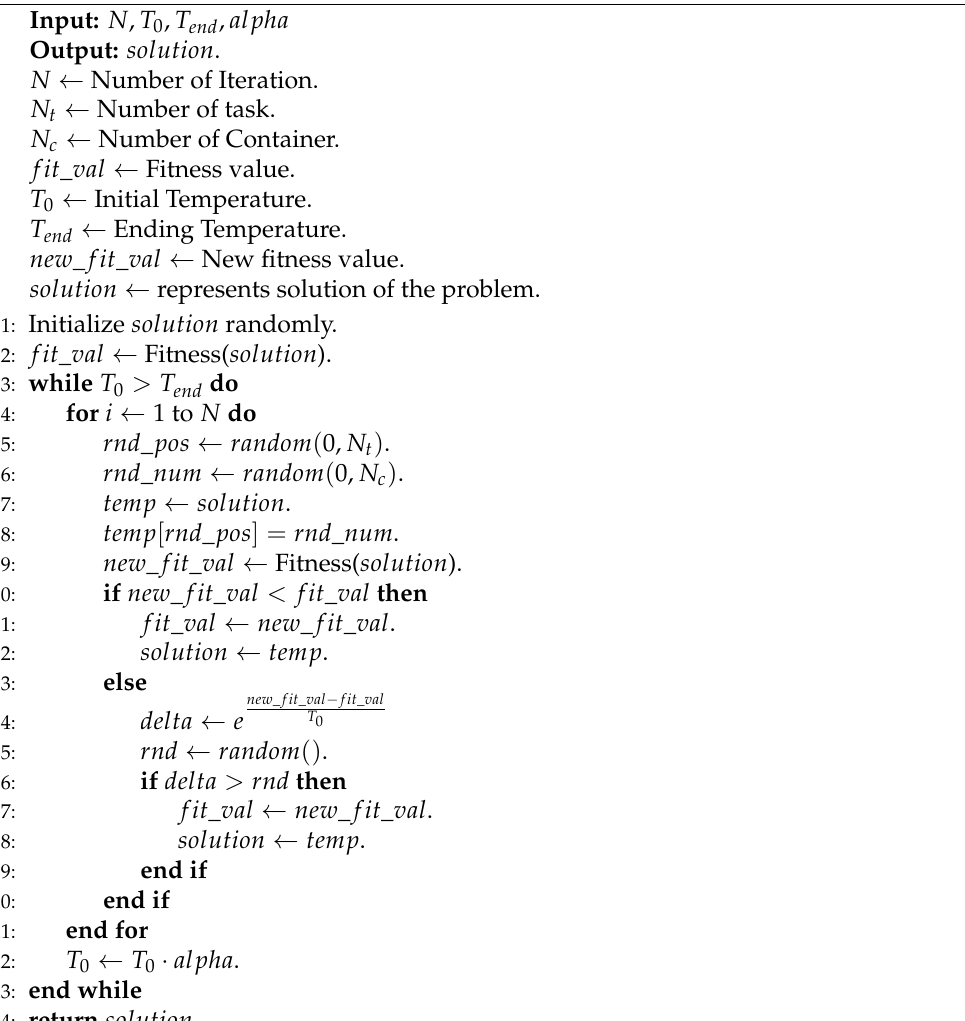
Algorithm 3 Simulated Annealing